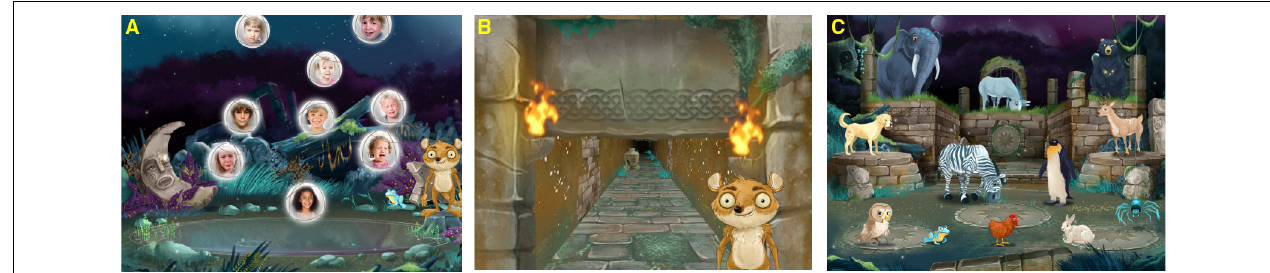
FIGURE 1 | Three paradigms suitable for an outcome measure for sleep dependent learning. (A) Target detection of emotional stimuli: a continuous performance task which uses children’s faces as stimuli. Targets are smiling expressions and non-targets are neutral or sad expressions of emotion. Performance is evaluated through reaction time, intra-individual standard deviation of reaction time, commission and omission errors. (B) Spatial learning: